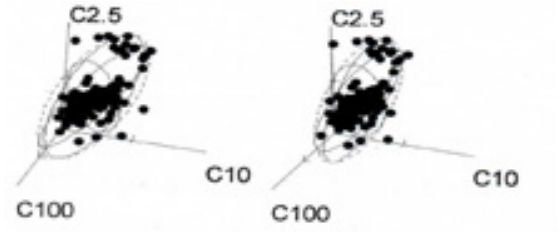
Figure 8. Stereo-pair scatter plots of contrast visual acuities at high, medium and low contrast levels (100%, 10% and 2.5% respectively) of diabetic patients without obvious diabetic retinopathy. A surface of constant probability density (or 95% distribution ellipsoid) is represented. The origin is 0 LogMAR or Snellen 6/6. Tick intervals are at 1 LogMAR or a change to 6/60 (or 0.1 in decimal notation). The edge of any axis is equal 2 LogMAR (or 6/600 or 0.01).